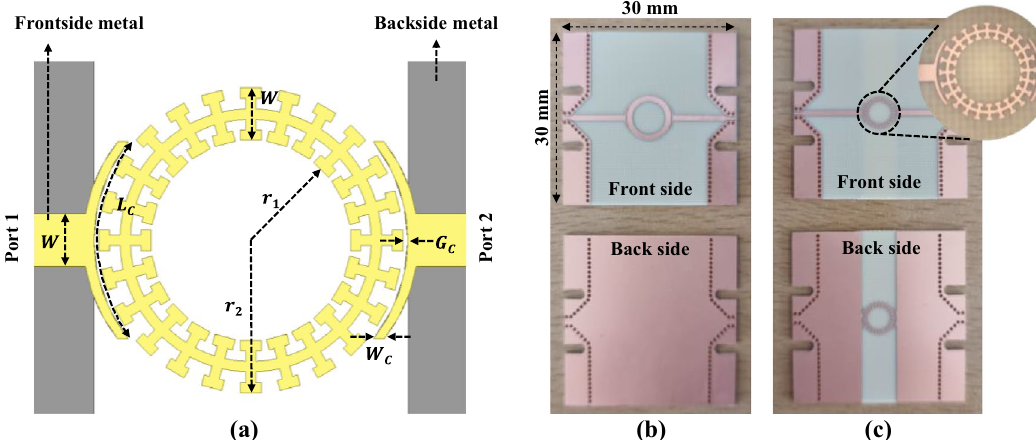
Figure 11. Microwave ring resonators. ( a ) Layout of DS SSPP ring resonator. ( b ) Fabricated microstrip ring resonator. ( c ) Fabricated DS SSPP ring resonator. Both resonators have the same coupling structure in which W c = 0.20 mm, L c = 4.05 mm, and G c = 0.10